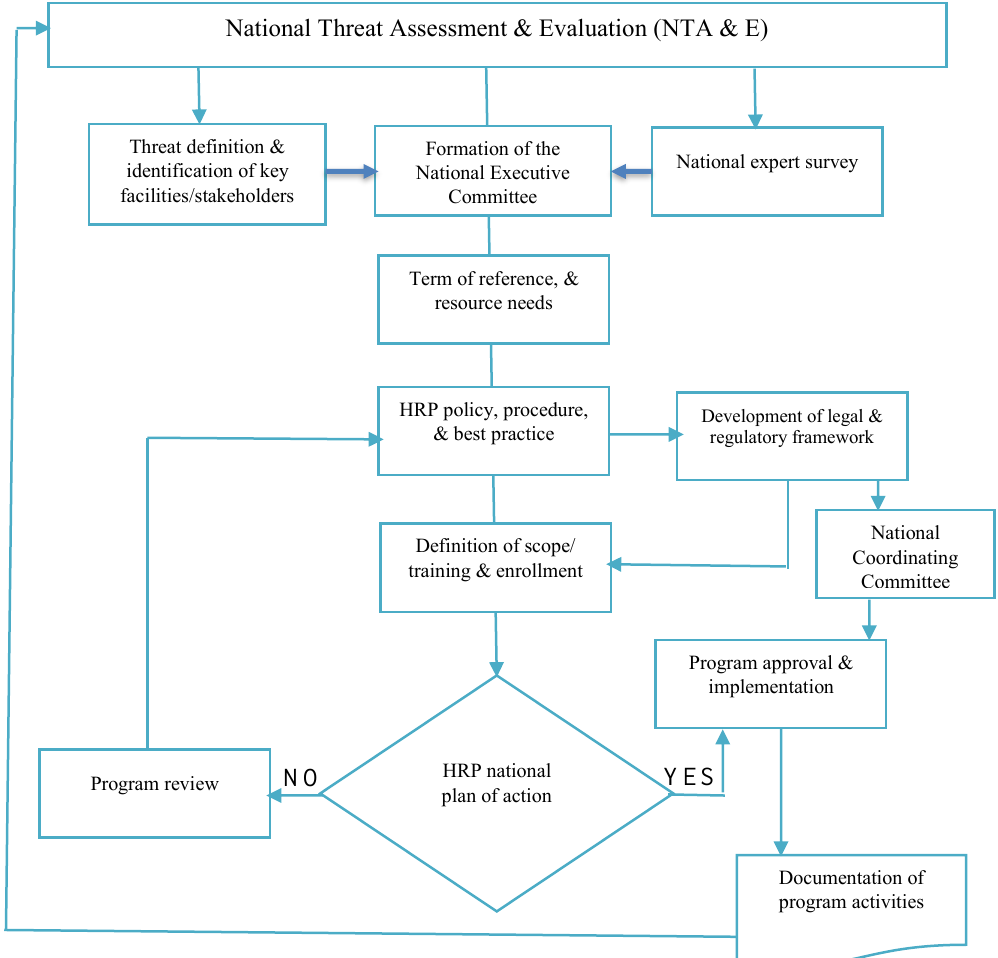
Figure 12. Recommended organizational structure for the implementation of an HRP in